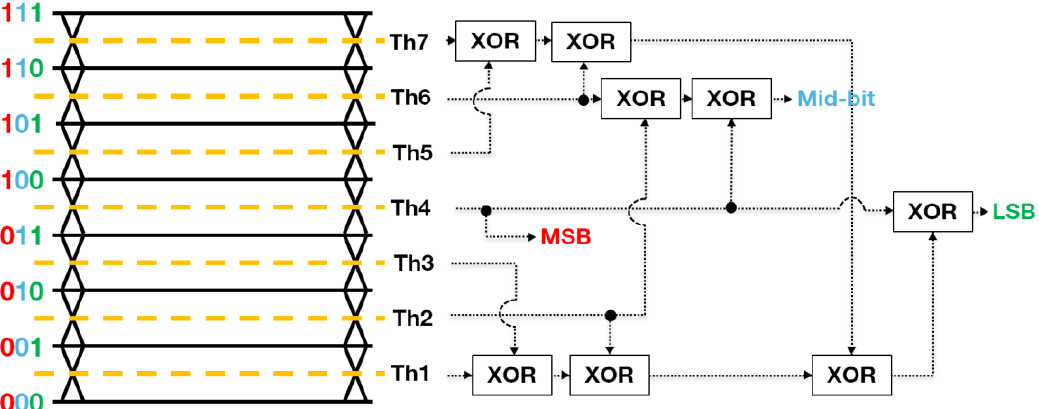
Figure 5. Natural labeling PAM8 decoder.